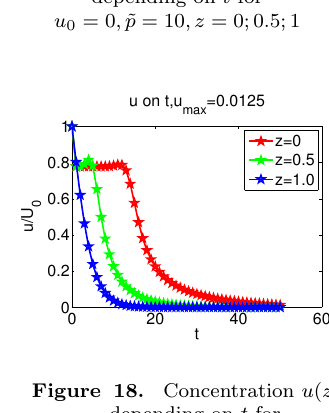
Figure 18. Concentration u ( z,t ) depending on t for u 0 = 1 , ˜ p = 10 ,z = 0;0 .